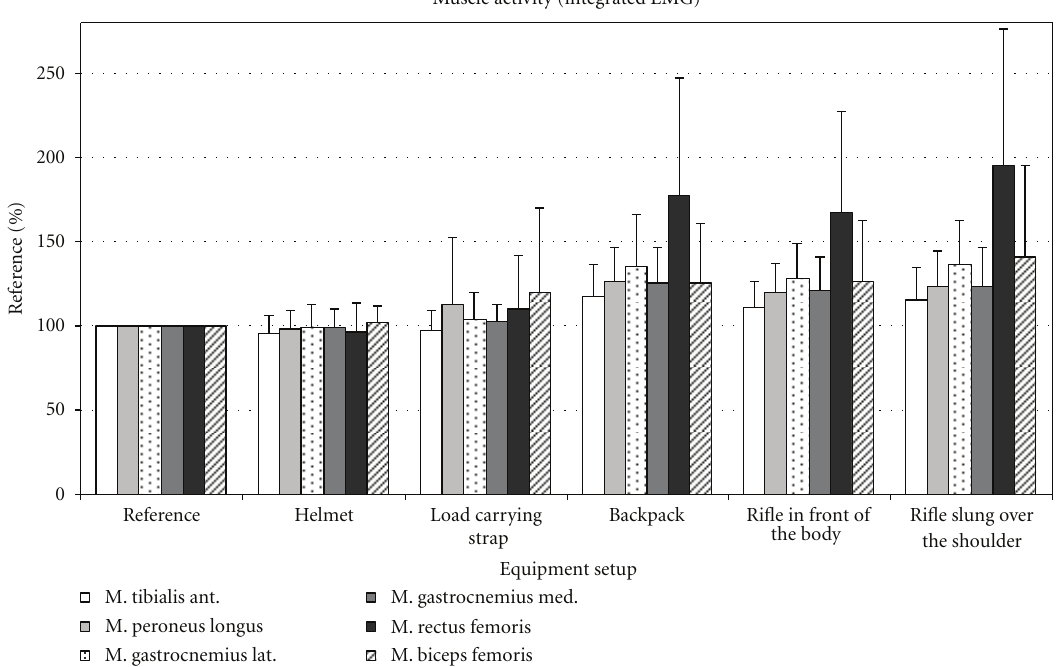
Figure 4: Integrated EMG in percent compared to the mean integrated EMG of the reference